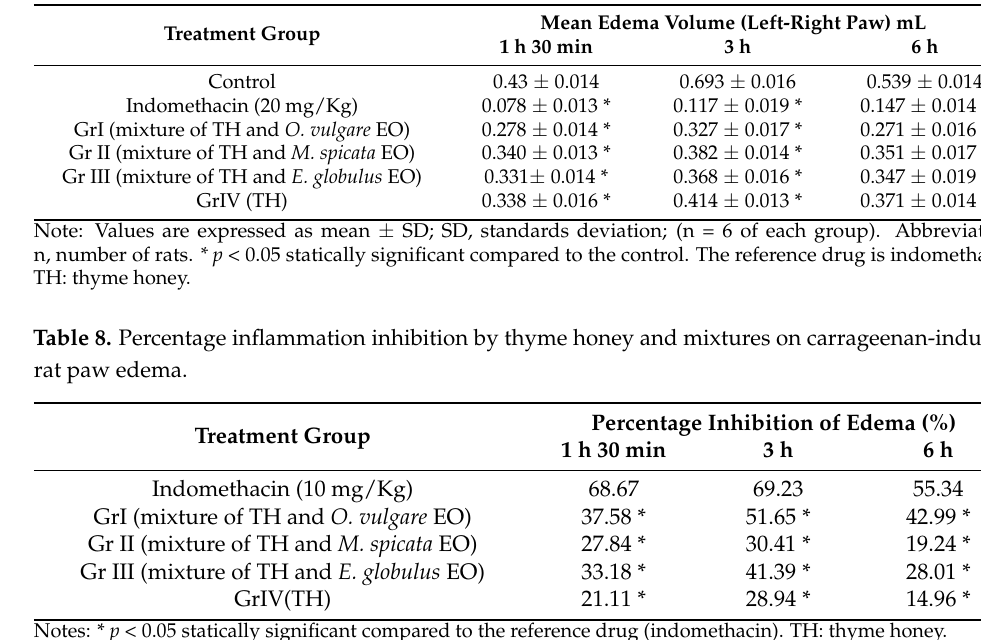
Table 7. Effect of thyme honey and mixtures on trauma-induced rat paw edema.